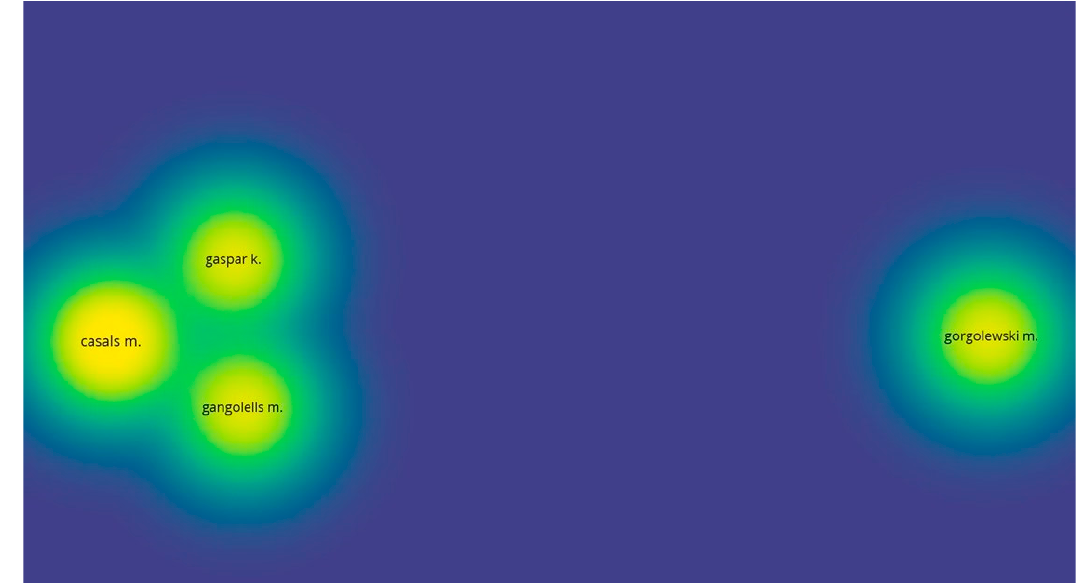
Figure 6. Density visualization of the authors with at least two publications on the topic “ thermal transmittance estimation of building *” (source: authors’ elaboration using VOSviewer, based on Scopus data).